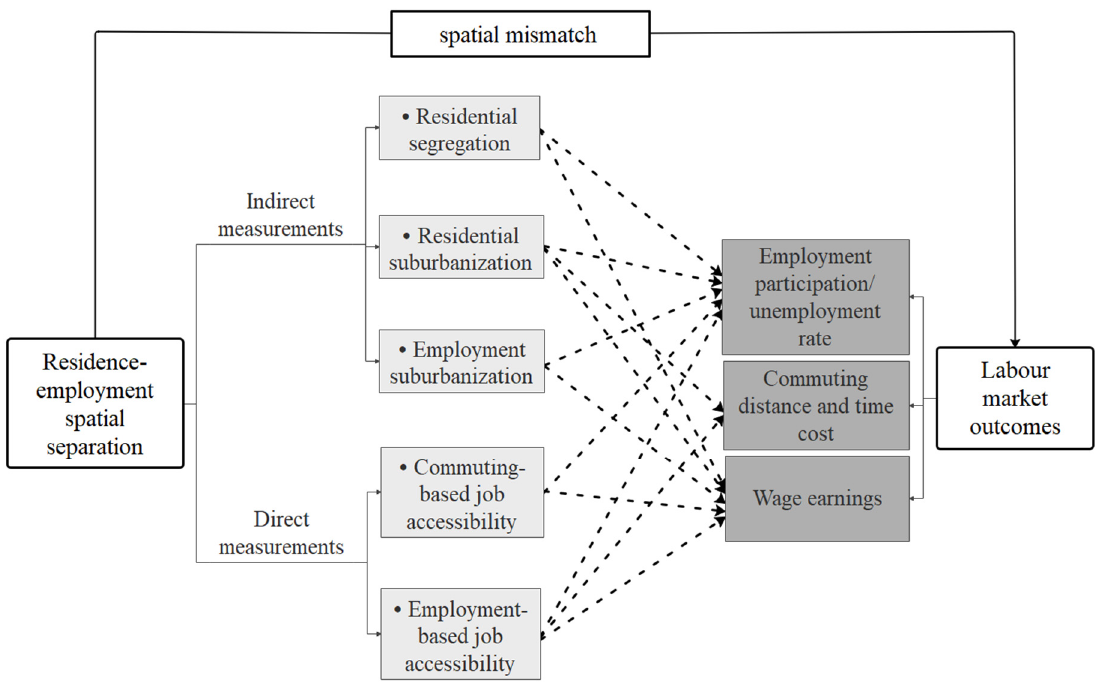
Figure 2. The measure of Job Accessibility and Spatial Mismatch.